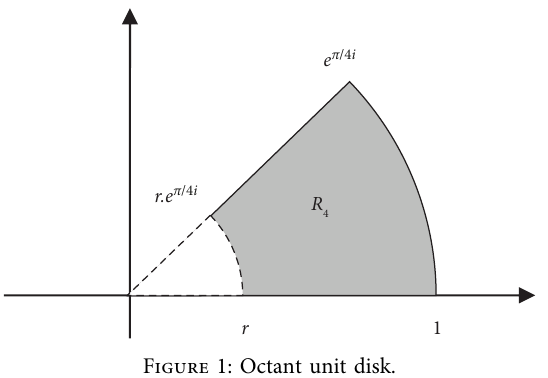
Figure 1: Octant unit